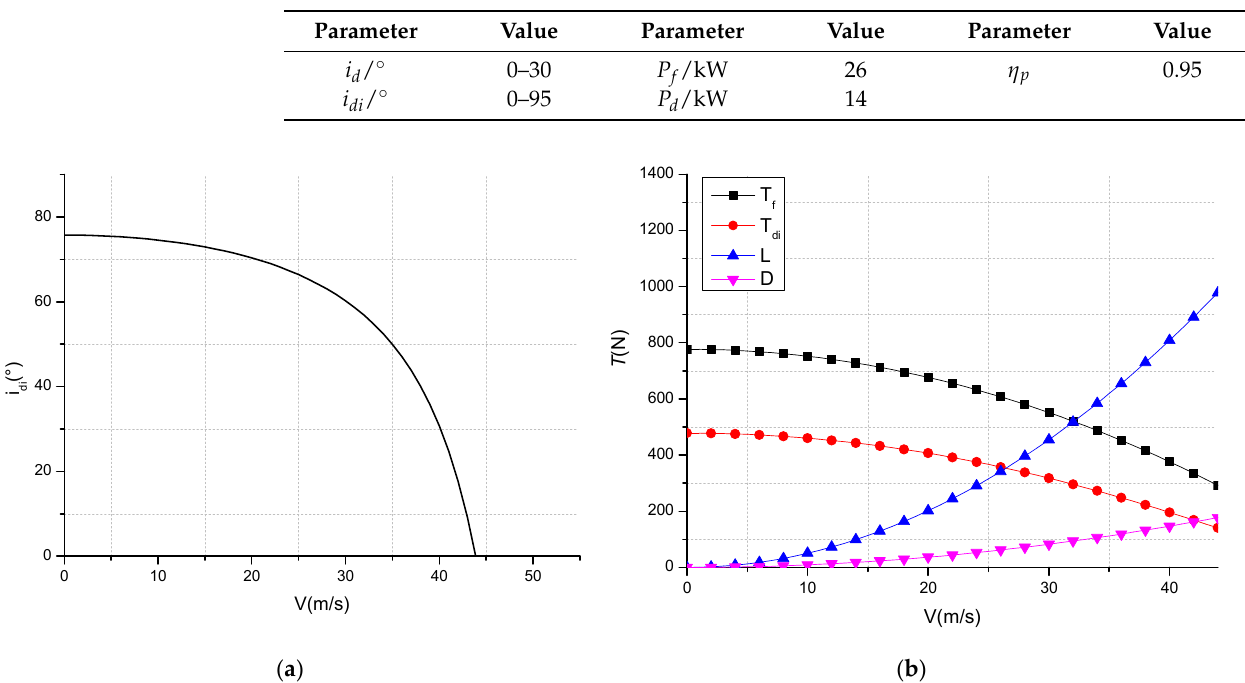
Figure 6. UAV lift and drag coefficient schematic diagram of force during transition flight. Table 1. Calculation parameters and empirical coefficients.